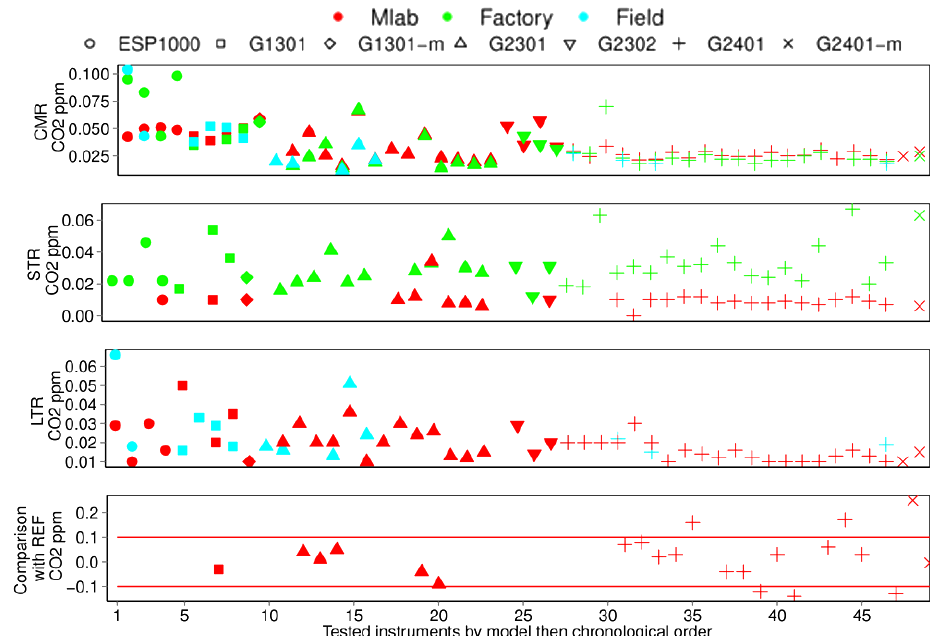
Figure 3. Results for CO 2 . First panel: continuous measurement repeatability (CMR) at the factory (as defined), at the MLab (on the raw data) and in the field (as defined). Second panel: short-term repeatability (STR) at the factory and the MLab. Third panel: long-term repeatability (LTR) at the MLab and in the field. Fourth panel: comparison with reference instrument, average difference at the MLab. The horizontal lines show the WMO compatibility goals.